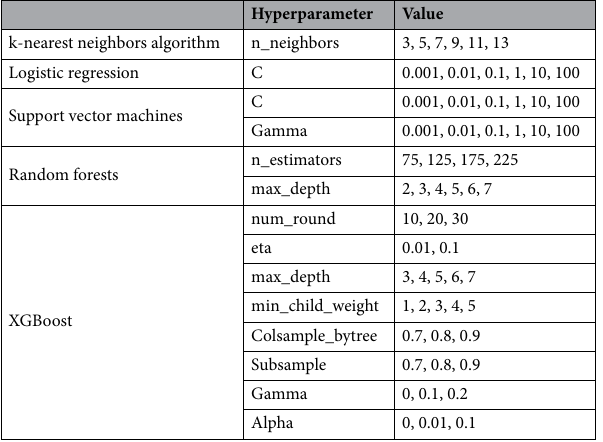
Table 1. Manually tuned hyperparameters and their values in each machine learning